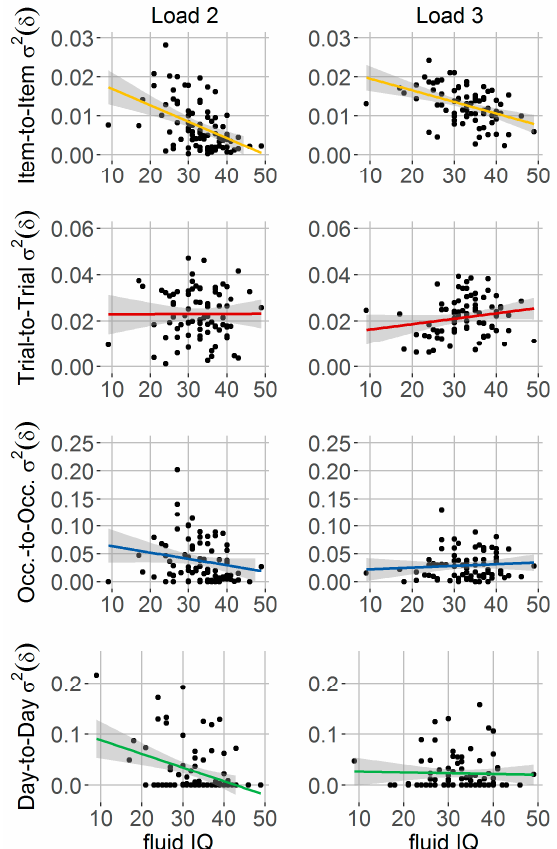
Figure 5. Relationship between fluid intelligence and variability of spatial precision. Children ( n = 82) with higher scores of fluid intelligence measures (i.e., CFT 20-R raw scores) (x-axis) showed lower item-to-item variability of spatial precision (cf. first row, Load 2/3: p < 0.05). No such relationship was found for variability of spatial precision across trials (second row), occasions (third row), or days (fourth row).